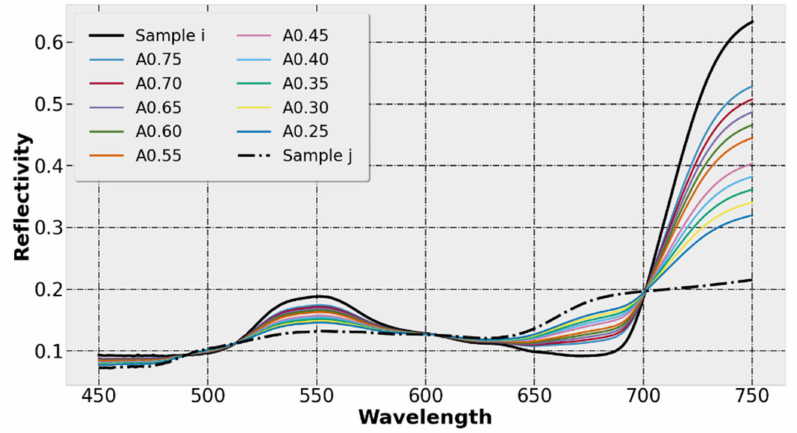
Figure 6. Mixed reflectivity of pixel i and pixel j .